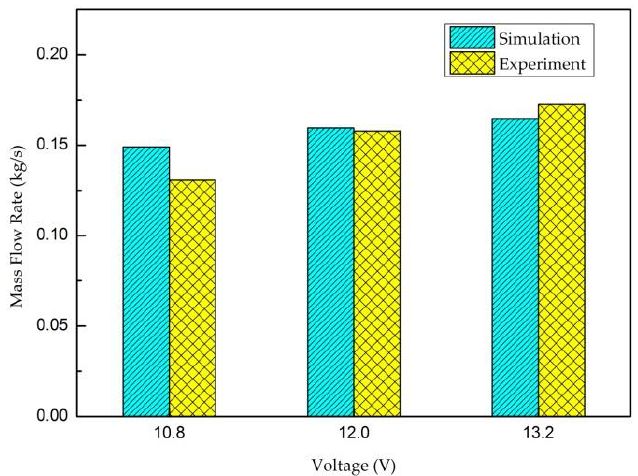
Figure 15. Mass flow rate measured under simulated and experimental conditions at different operating voltages of the centrifugal fan.